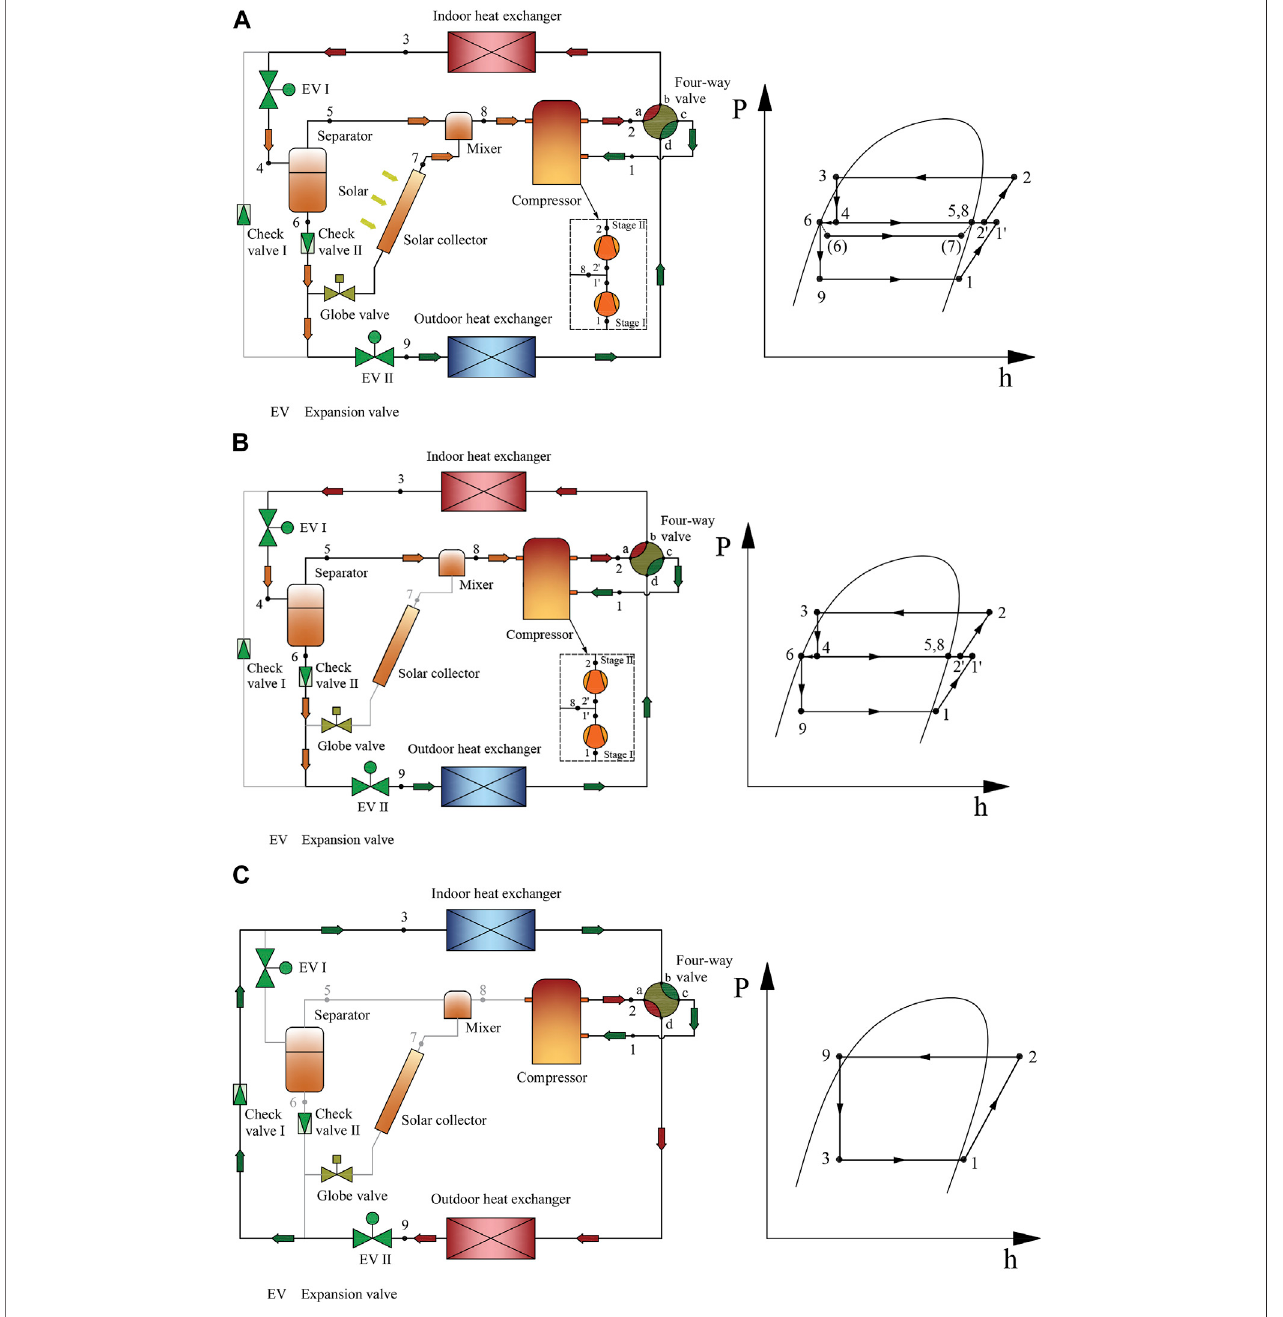
FIGURE 1 | Schematic and P-h diagrams of three working modes for the DS-VIHP system: DS mode (A) , AS mode, (B) and cooling mode (C) .